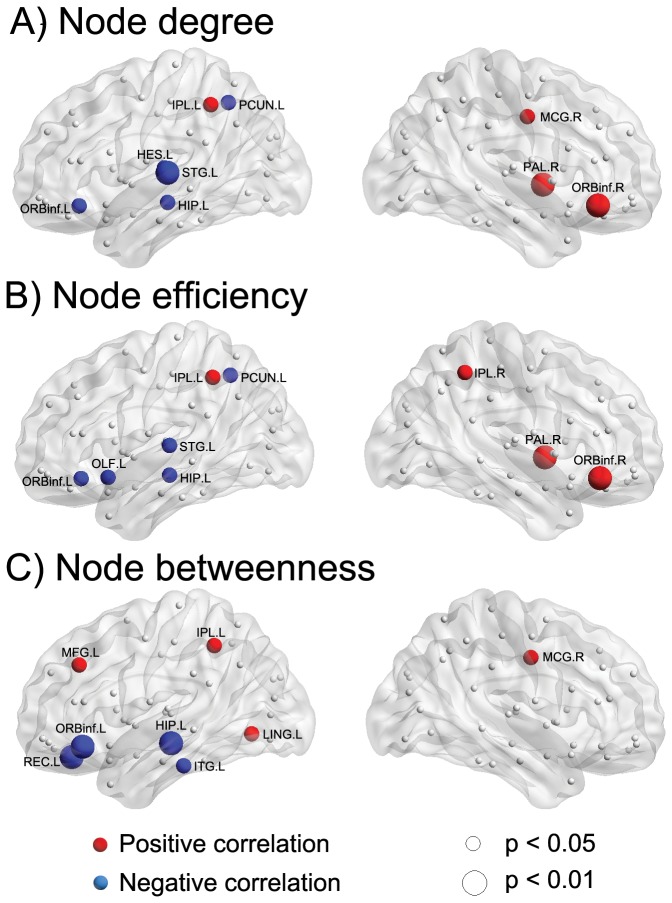
Effect of IQ on regional nodal properties.The significant positive and negative correlation between IQ and regional nodal parameters are shown in red and blue, respectively. The significances of p<0.05 and p<0.01 (uncorrected) are indicated by spheres in small and big size, respectively. For a description of the abbreviations, see Table S1.